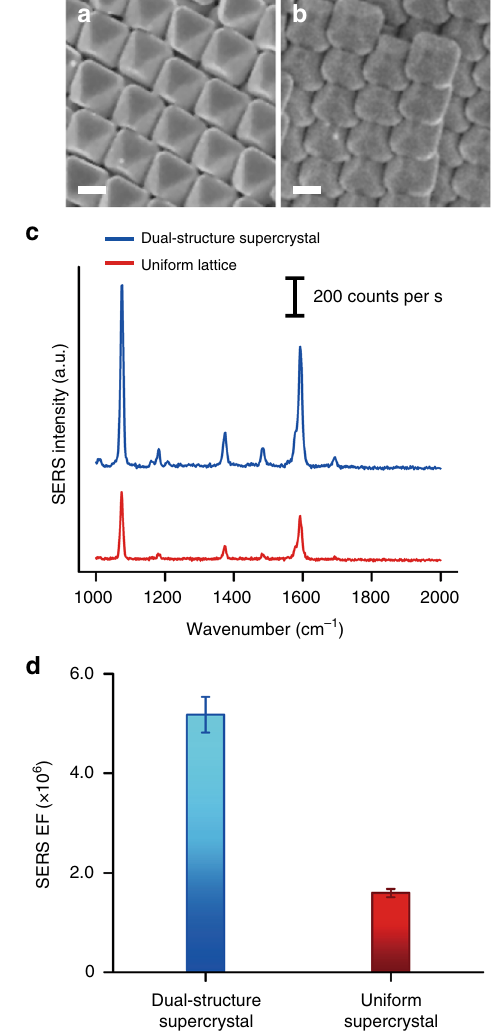
Fig. 5 Dual-structure supercrystal generates an overall higher SERS ef fi ciency. SEM images of the a dual-structure and b uniform bulk supercrystal of octahedra used for SERS experiments. All scale bars, 200 nm. Corresponding c SERS spectra and d EFs of 4-MBT from the respective assembled structures. Error bars in d are s.d. of at least 100 measurements over areas of 4 µ m 2 . 4-MBT,